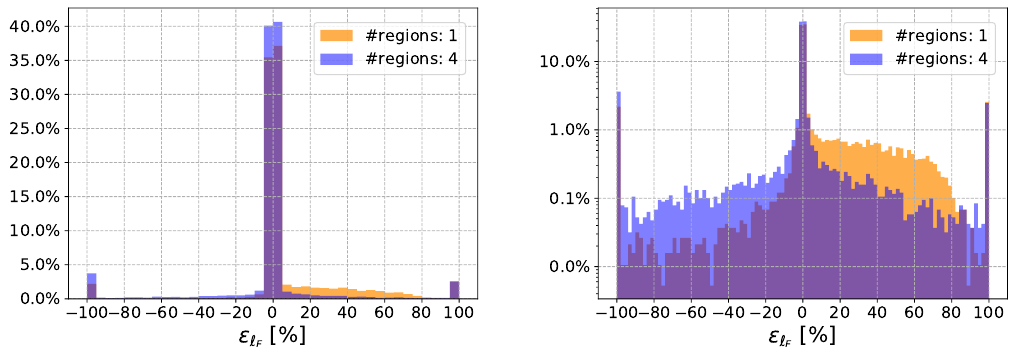
Figure 3. Results for the (cid:15) ‘ accuracy parameter in one sample flavour channel (specifically the F (cid:22) uu one) using either one (orange histogram) or four (blue histogram) precomputed grids. The same distribution is shown both in linear (left plot) and logarithmic (right plot) scale, where the bins at the edges account for overflow ( j (cid:15) ‘ j > 100% F